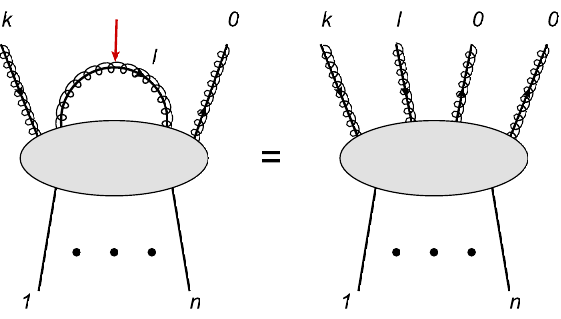
Figure 8 . Evaluation of residue at the pole of loop propagator (cut) resulting in the forward limit. Red arrow indicates which propagator we are cutting.